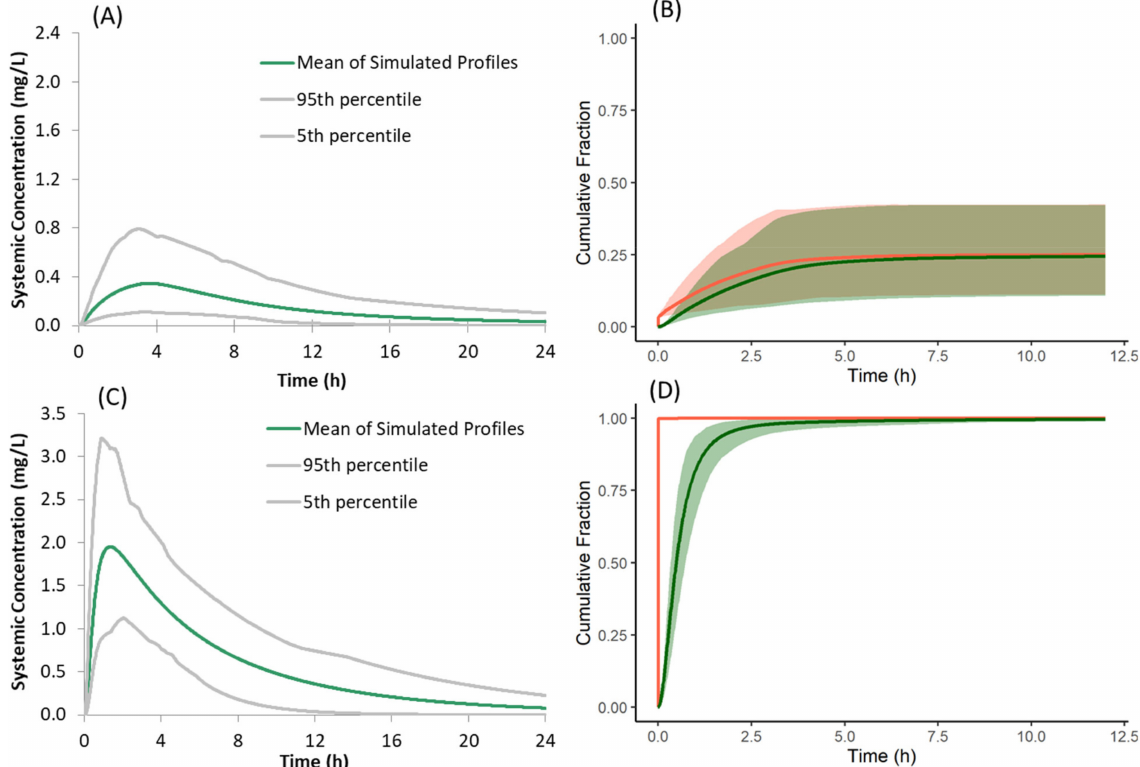
Figure 12. ( A , C ) Simulated plasma concentration time profiles and ( B , D ) cumulative fraction of dose dissolved (red) and absorbed (green) of the model compound following oral administration of 150 mg of the salt form under fasted conditions with famotidine co-dosing when the mechanistic Surface pH model is not selected ( A , B ); when Solid State 2 (free form) is not used in the model ( C , D